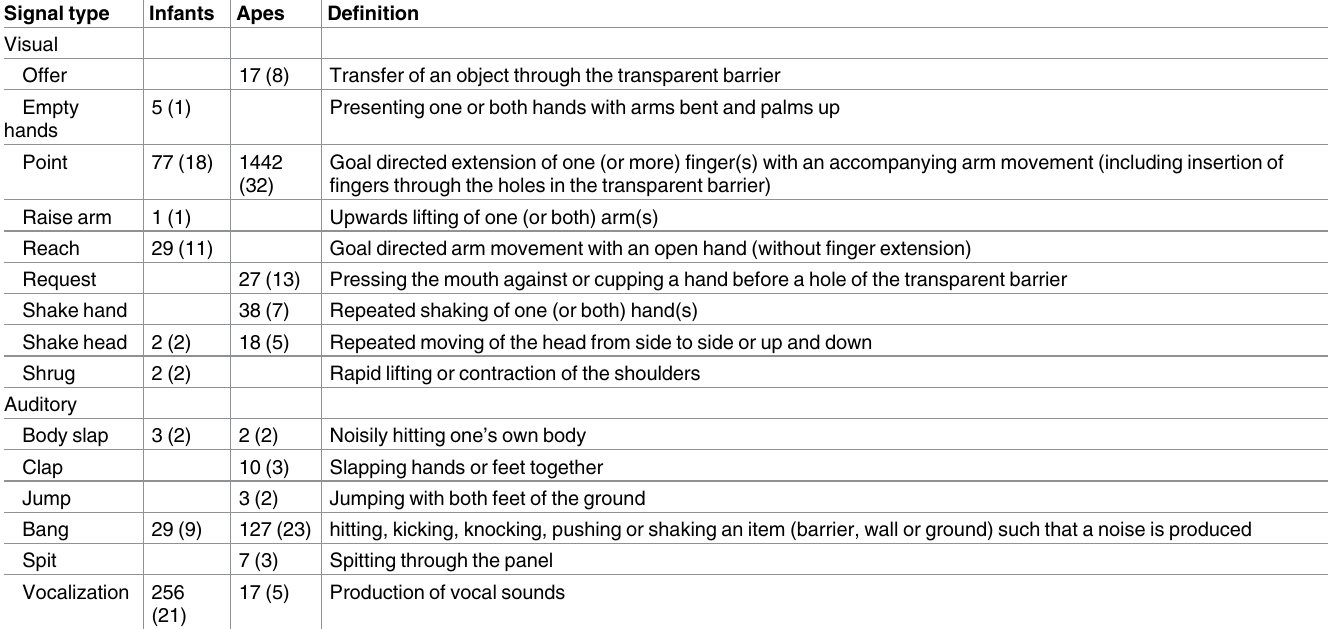
Table 1. Definition of communicative behaviours classified according to their respective sensory